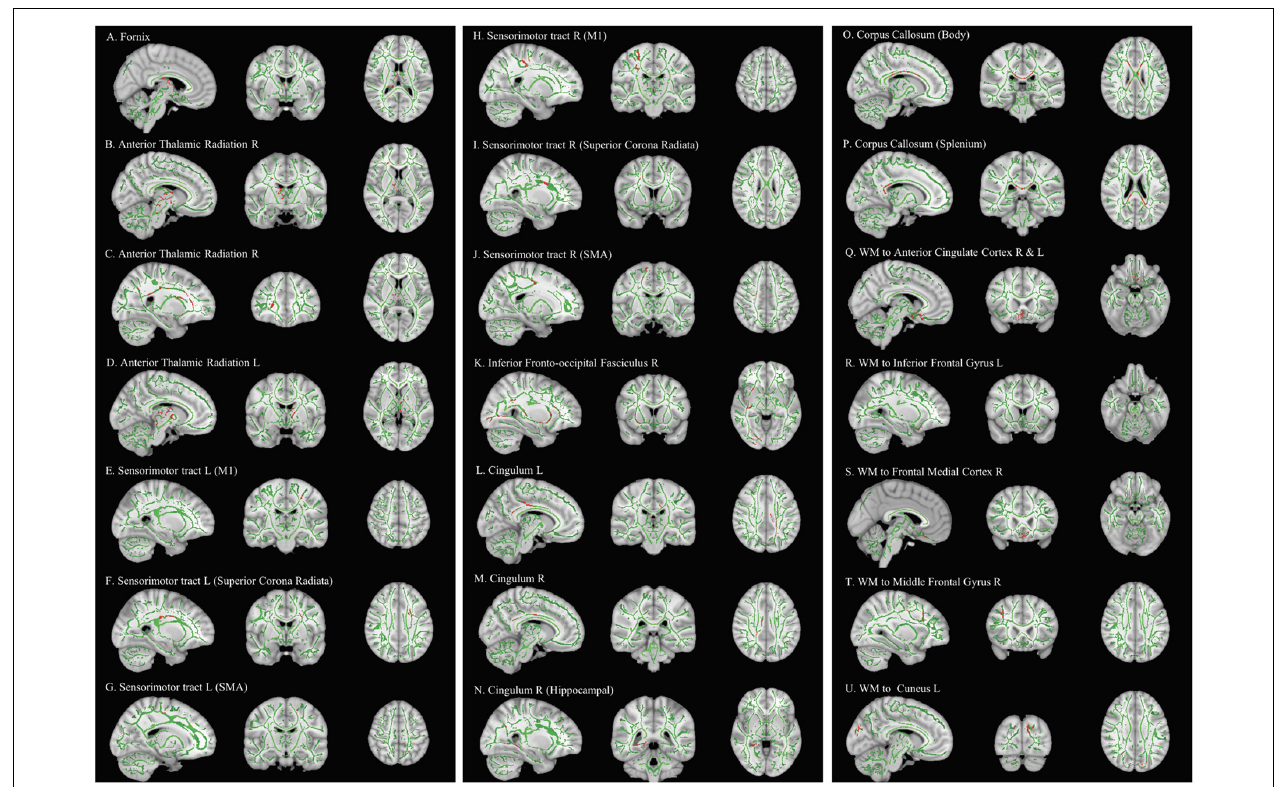
FIGURE 3 | Effect of intervention on fractional anisotropy in children with DCD. In these images, the white matter skeleton is shown in green and brain structures with altered fractional anisotropy are shown in red. L, left; M1, primary motor cortex; R, right; SMA, supplementary motor area; WM, white